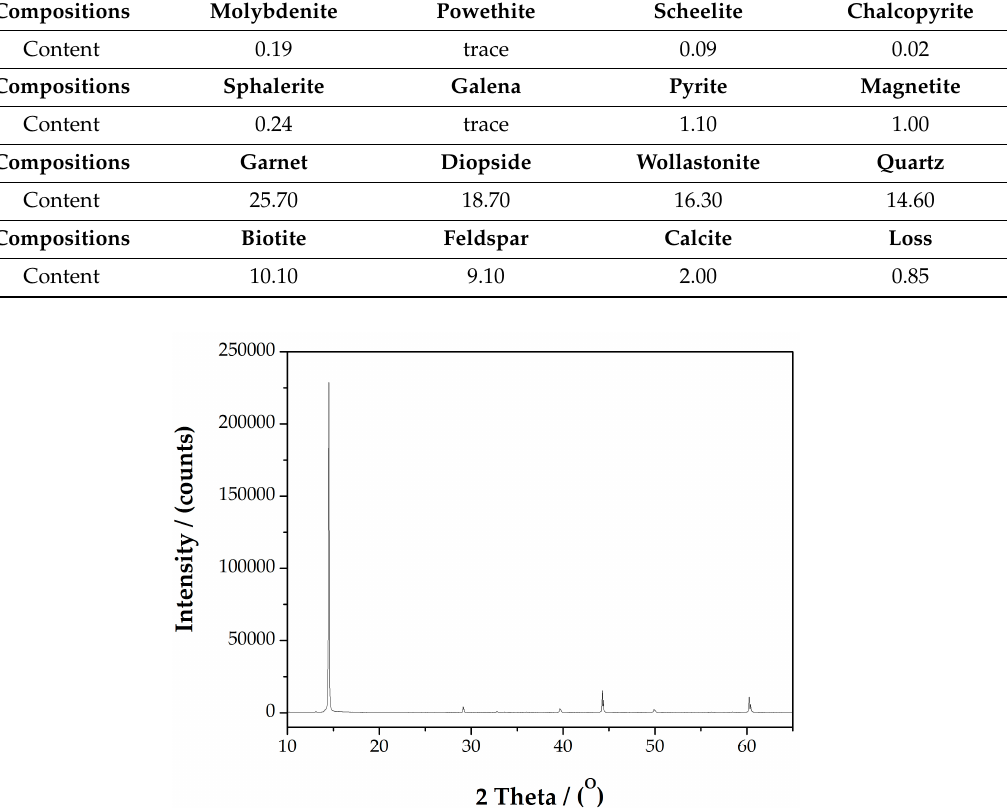
Table 2. The mineralogical composition of the actual Mo ore (wt %).